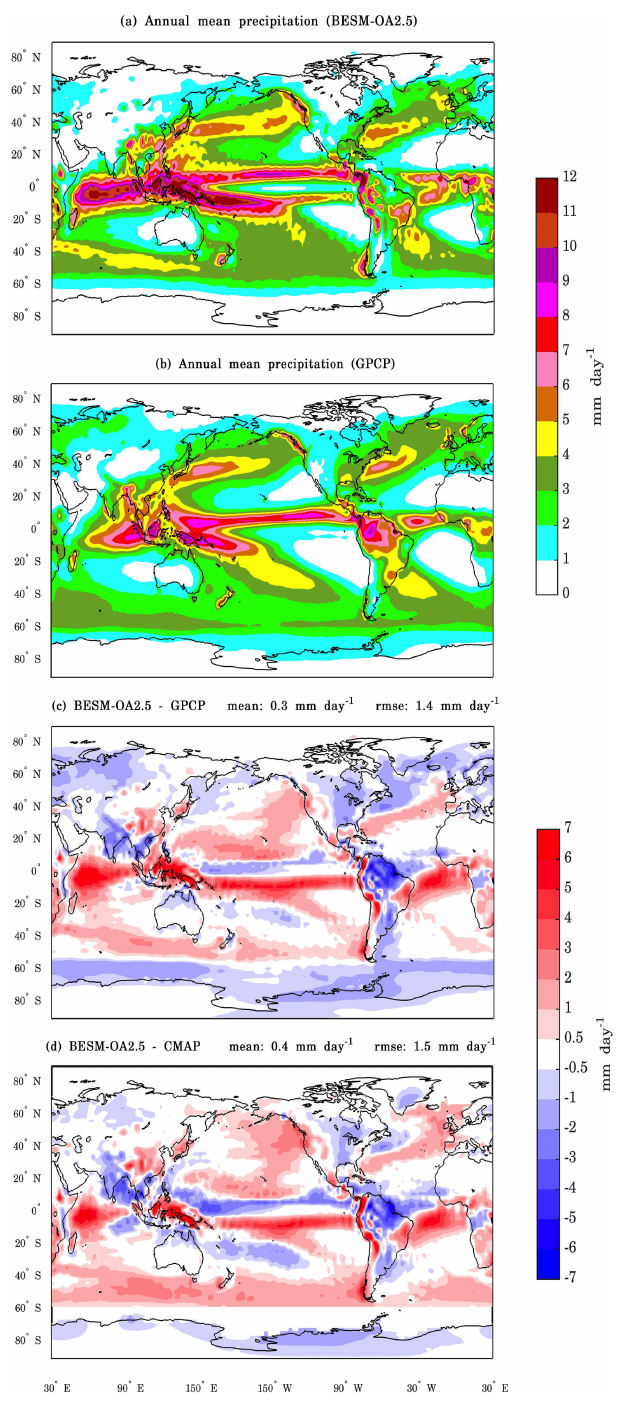
Figure 4. Spatial maps of the annual mean precipitation for (a) BESM-OA2.5, (b) GPCP, (c) the bias of BESM-OA2.5 rela- tive to GPCP, and (d) the bias of BESM-OA2.5 relative to CMAP. The average values were computed over the periods 1971–2000 (for BESM-OA2.5) and 1979–2008 (for GPCP and CMAP). Units are in millimeters per day.